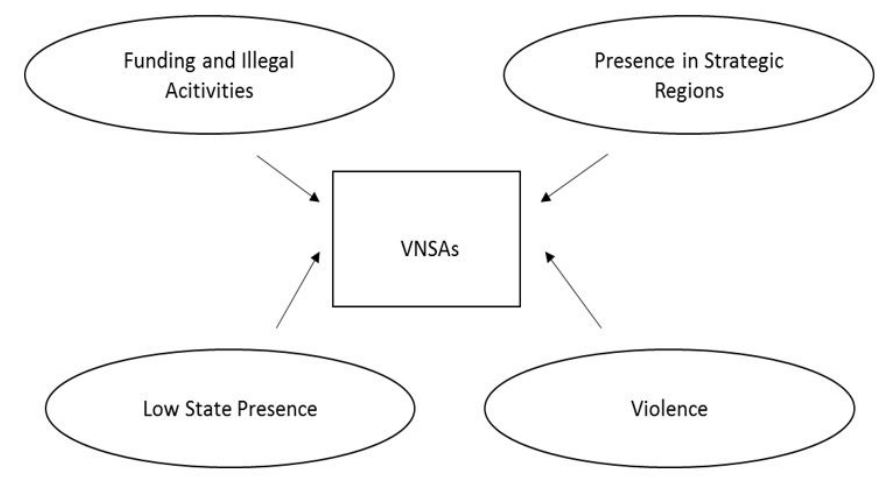
Figure 2. Dimensions on the Performance of VNSAs. Source: Developed by the authors, based on the Literature.